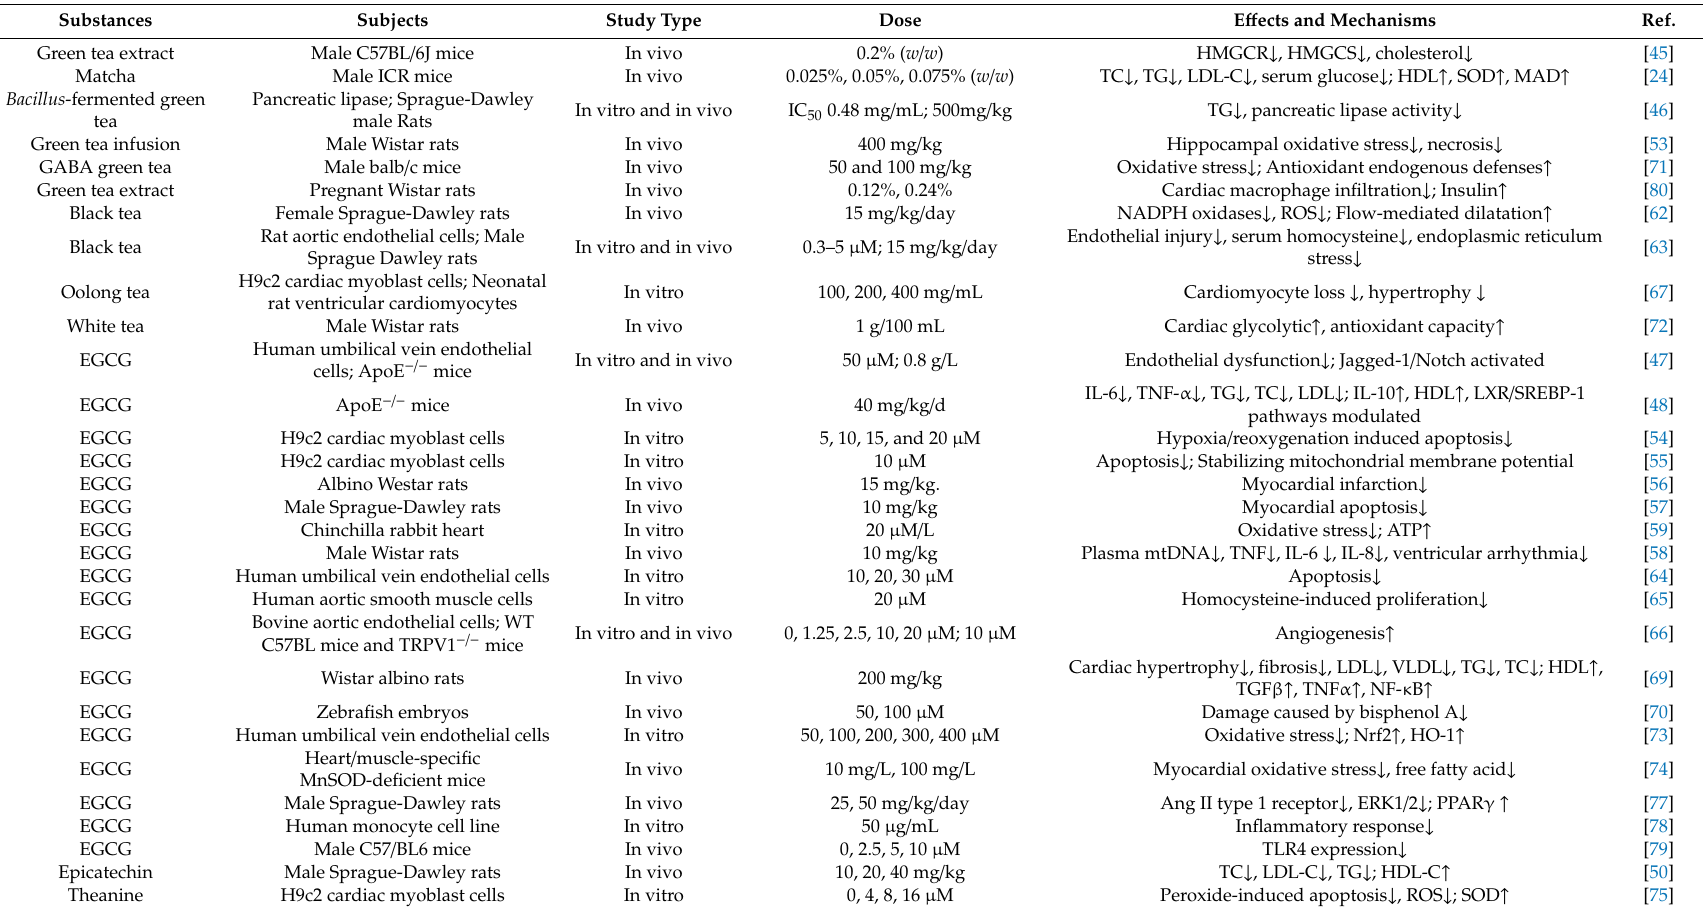
Table 2. The e ff ects and mechanisms of tea on CVDs based on in vitro and in vivo experimental